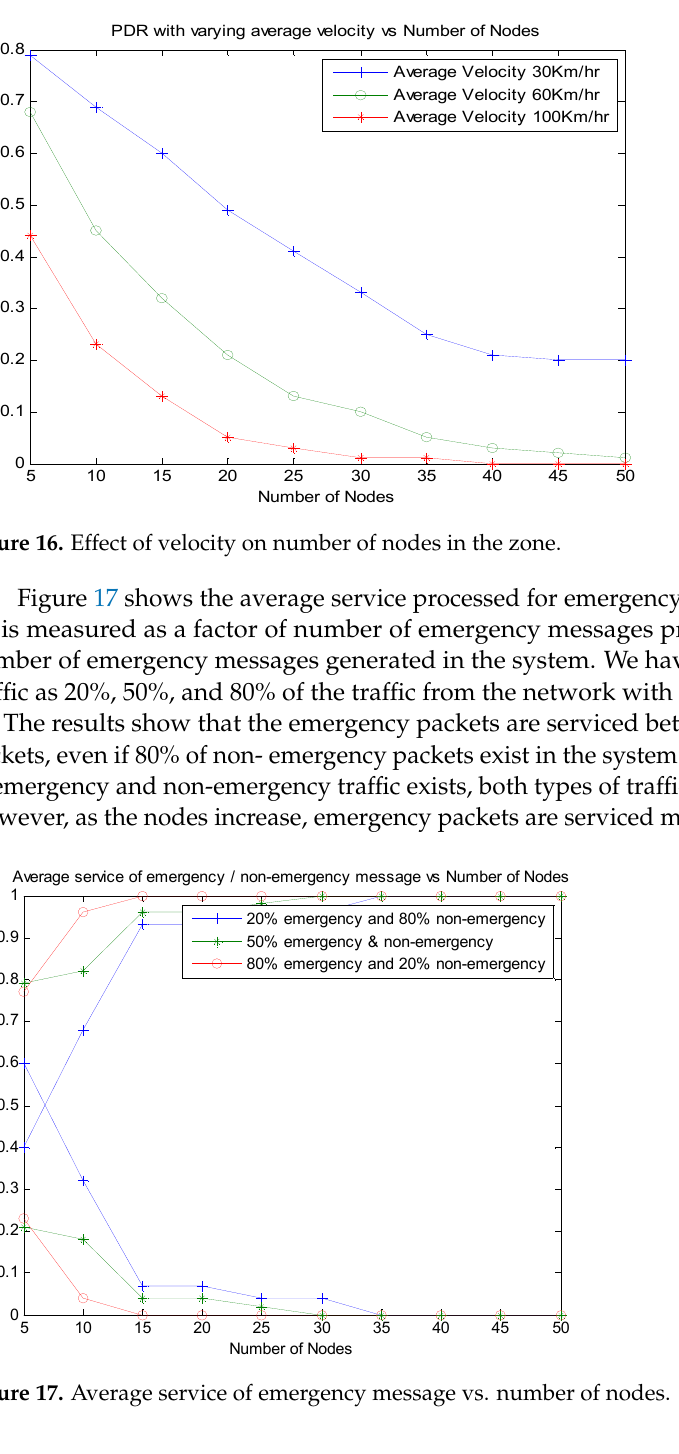
Figure 15. Number of nodes in a probable accident zone vs. number of nodes. Another factor that has an impact on the priority of an emergency packet from a node at an instant is the average velocity of the platoon. Figure 16 shows the effect of velocity, and this parameter is measured under three average velocities of the platoon. The average velocities are varied as 30 km/h, 60 km/h, and 100 km/h. The results show that the packet delivery ratio increases when the average velocity of the platoon is 30 km/h. As the average velocity of the platoon increases, the packet delivery ratio decreases. However, as the number of vehicles increase, the packet delivery ratio of the nodes will decrease.